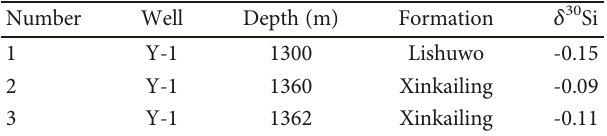
Figure 2: Shale cores from the X-1 well and Y-1 well. (a) Upper Ordovician Xinkailing Formation, 1360 m, Y-1 well, black siliceous shale; (b) upper Ordovician Wufeng Formation, 2523m, X-1 well, black siliceous shale; (c) upper Ordovician Xinkailing Formation, 1362 m, Y-1 well, grey siliceous shale; (d) upper Ordovician Wufeng Formation, 2523 m, X-1 well, black siliceous shale with a large amount of graptolites; (e) no. 1 member of the lower Silurian Lishuwo Formation, 1336 m, Y-1 well, organic rich shale; (f) no. 1 member of the lower Silurian Longmaxi Formation, 2520m, X-1 well, organic rich shale; see Figure 1 for the location of the outcrop and well site. Table 1: Silicon isotope analysis of the upper Ordovician-lower Silurian shale in the Y-1 well. See Figure 1 for the well